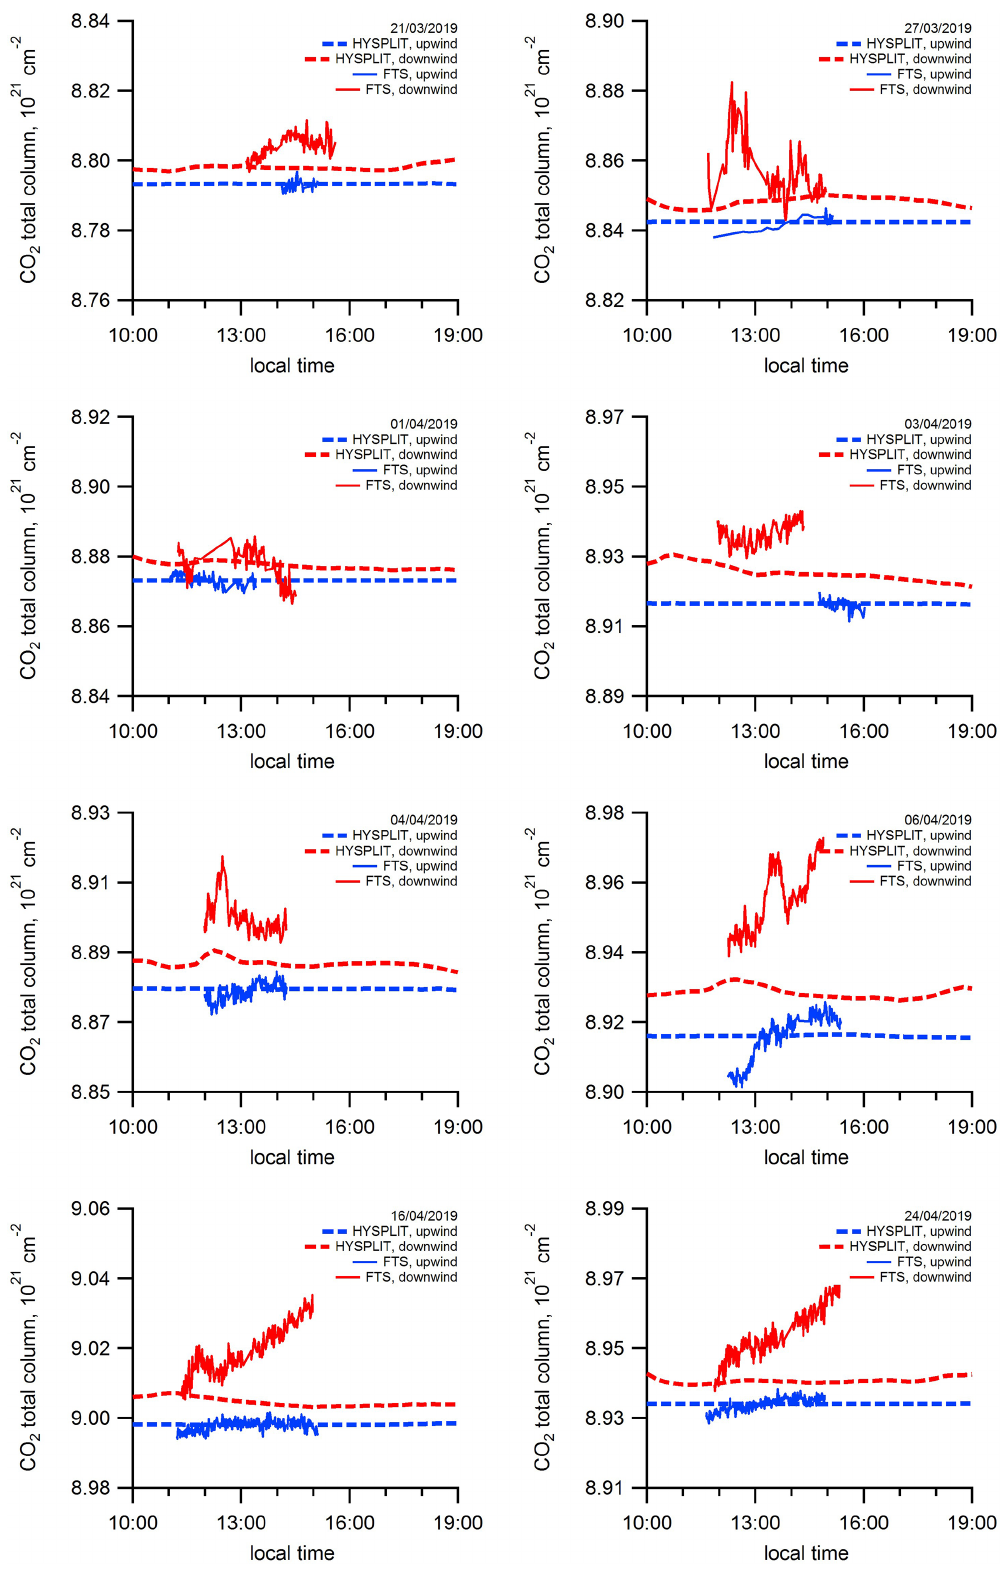
Figure B1. Time series of measured (FTS) and simulated (HYSPLIT; without scaling of the ODIAC emissions data) CO 2 total column at the upwind (blue lines) and downwind (red lines) locations for selected campaign days in